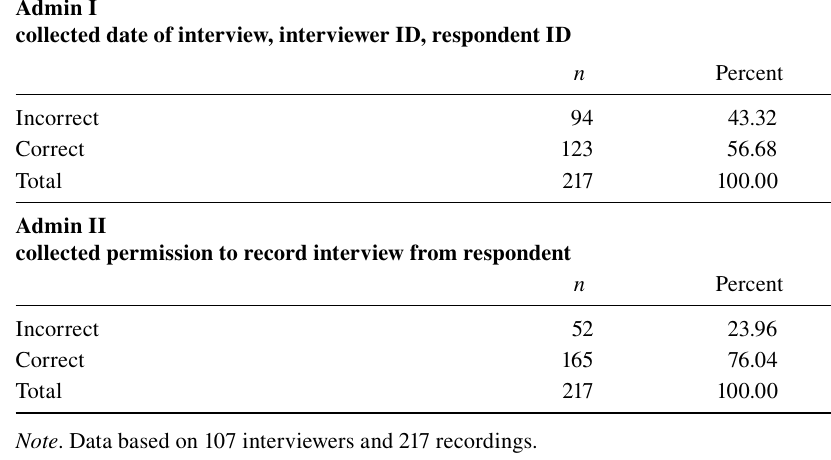
Interviewer behavior for collecting administrative